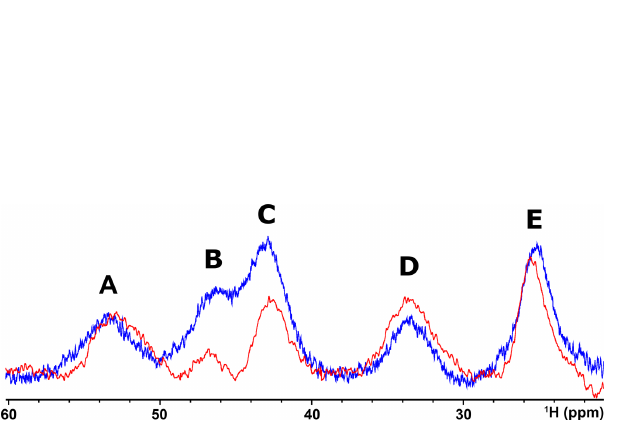
Figure A5. 1 H NMR spectrum of oxidized [ Fe 2 S 2 ] 2 + mitoNEET in 90% H 2 O and 10% D 2 O (blue line) and in 100% D 2 O (red line), at 600MHz,